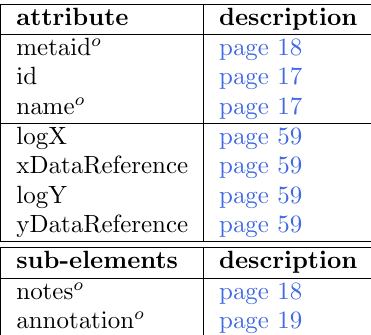
Listing 2.60 shows the use of the curve element in a SED-ML file as defined by the SED-ML Level 1 Version 2 XML